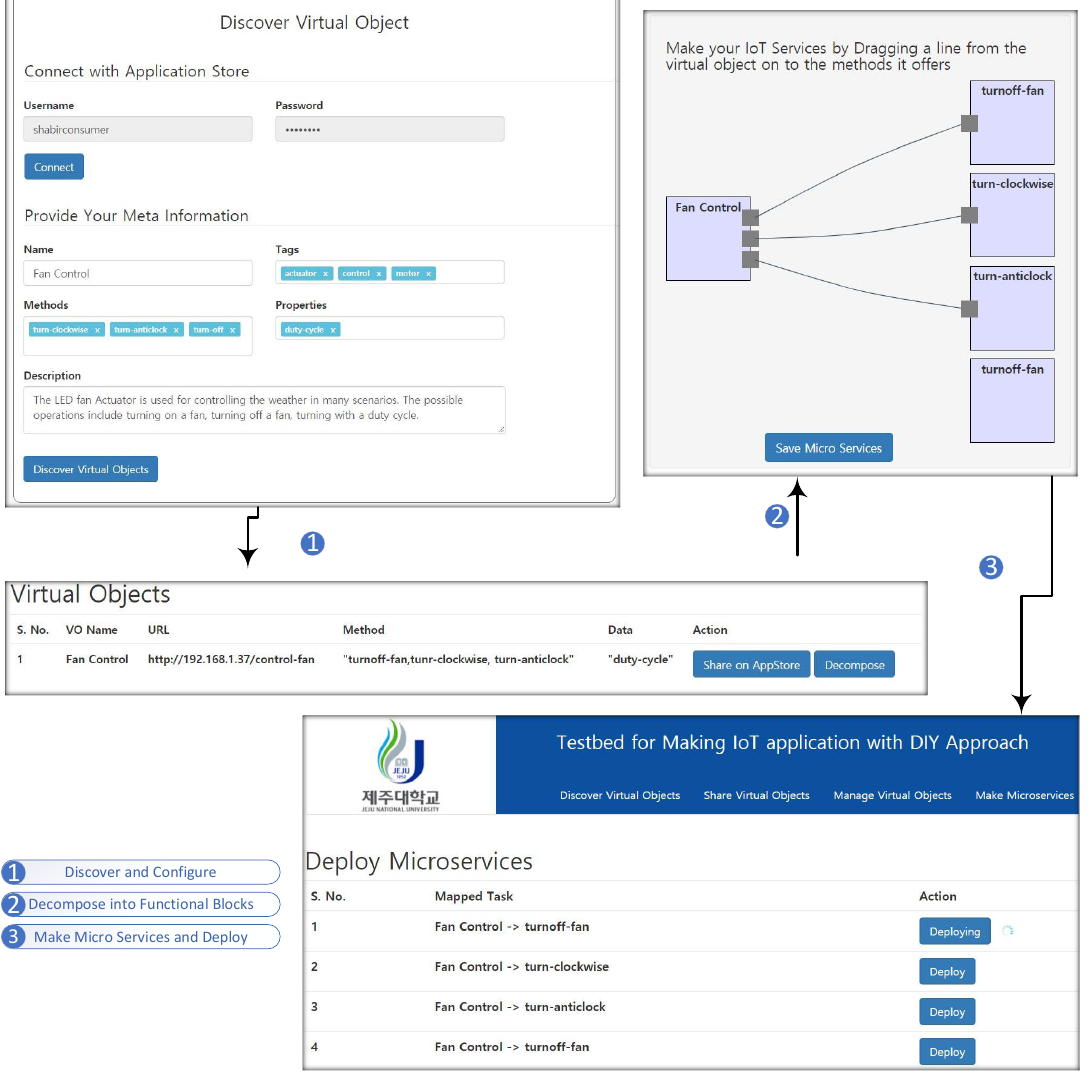
Figure 17. Functional flow of discovering virtual objects in use case